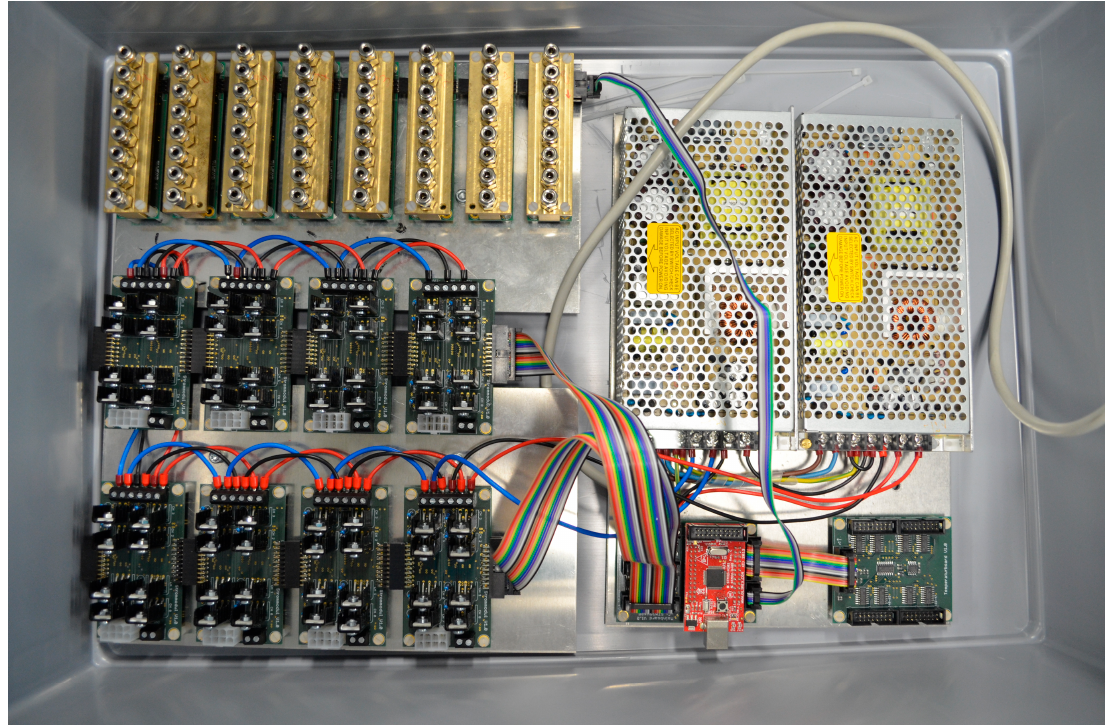
Figure 11. Top view of the assembled test system; current modules ( bottom , left ), light modules ( top , left ), temperature board ( bottom , right ), mainboard ( bottom , middle ), and the two power supply units ( top , right ).